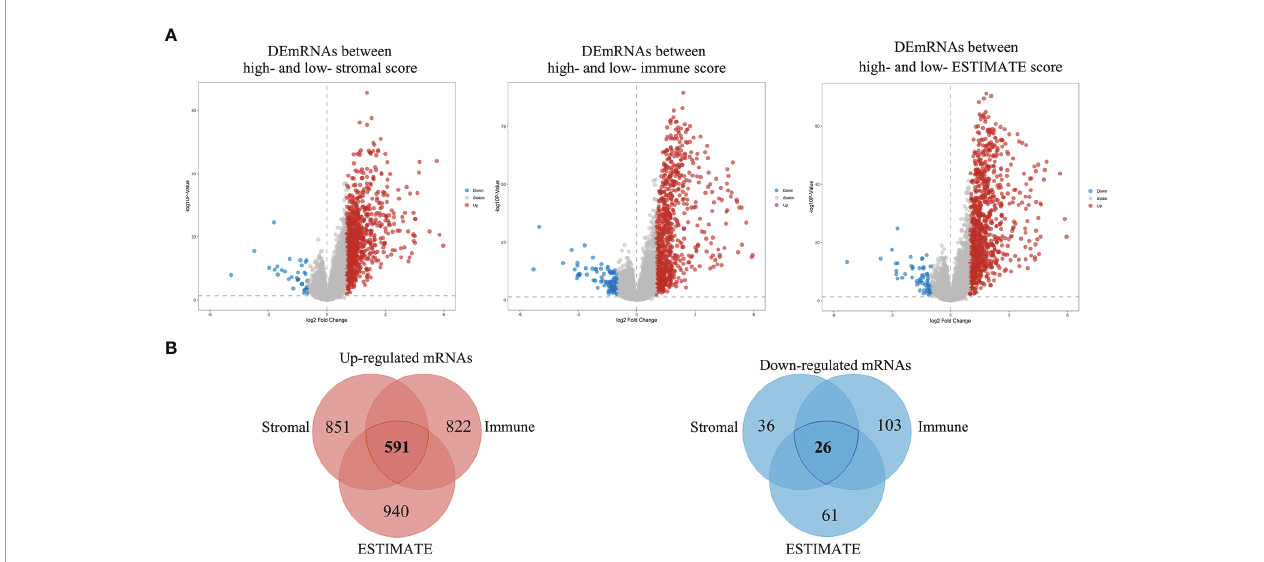
FIGURE 3 | Volcano plots and Venn diagrams of DEGs in the high and low stromal/immune/ESTIMATE score groups. (A) Volcano plot of DEGs in the high and low stromal/immune/ESTIMATE score groups. The red, blue and gray dots represent upregulated, downregulated and unchanged genes, respectively. (B) Venn diagrams showing the overlapping DEGs between the high- and low-stromal/immune/ESTIMATE score groups. The total number of distinct genes in each comparison group is presented as numbers within each circle, and the number presented in the overlapping regions indicates the number of shared genes among the three comparison